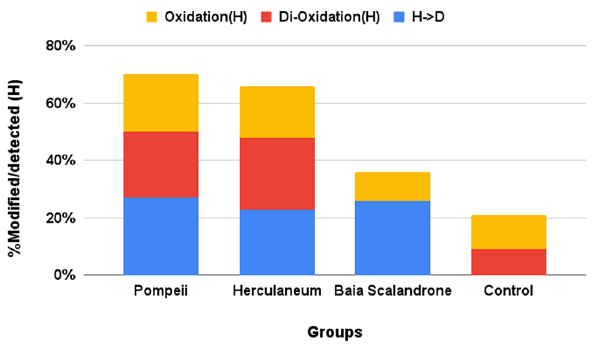
Figure 6. Extent of modified histidine residues, reported as percentage of modified over detected (modified plus unmodified) ones.